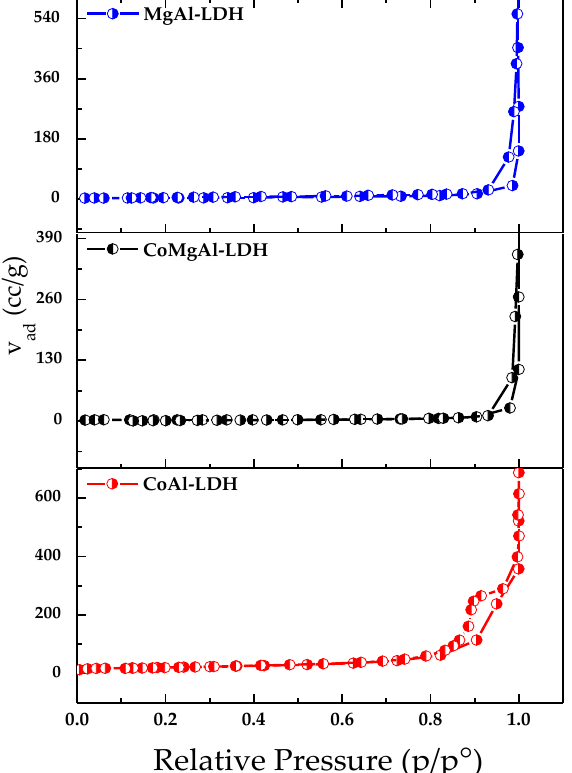
Figure 5. N 2 adsorption / desorption isotherms for di ff erent investigated materials.